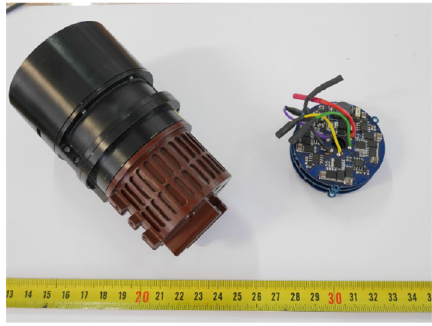
Fig. 4 SpaceClimber robotic actuator and FPGA electronics [20]